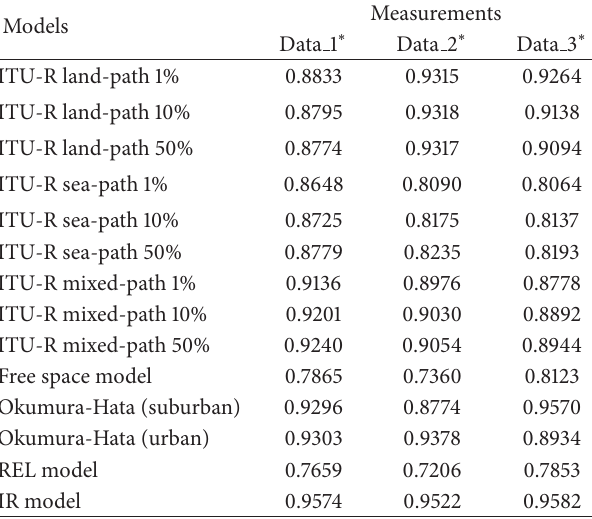
Table 3: The GRG-MAPE model selection results.